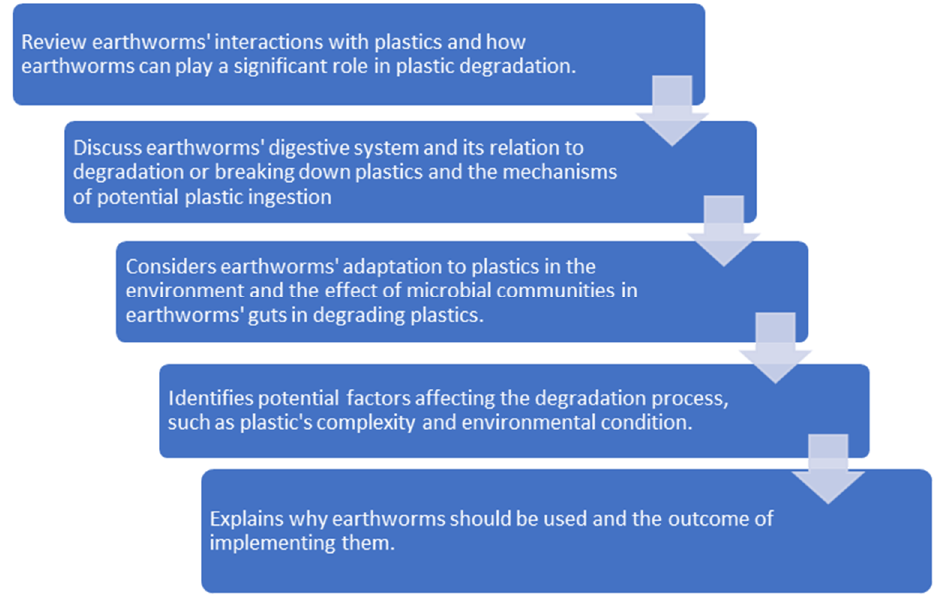
Figure 1. Purpose of this review